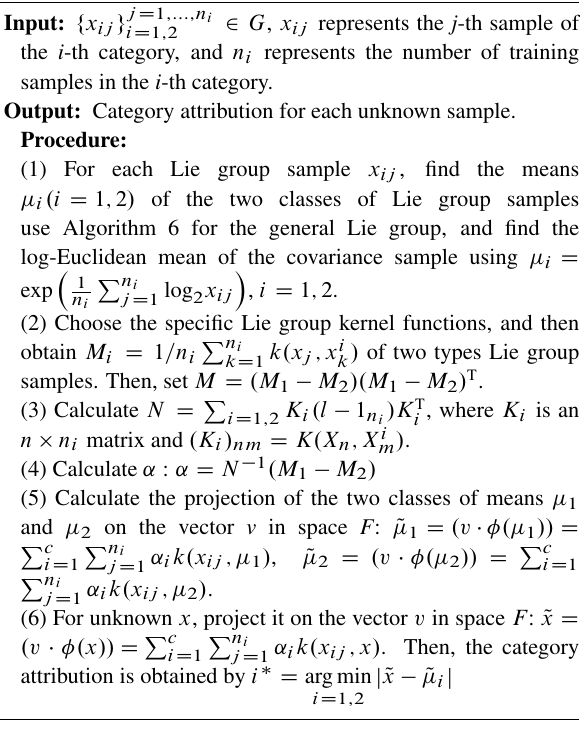
Algorithm 7. In this algorithm, the log-Euclidean mean is the global mean. From a geometric viewpoint,